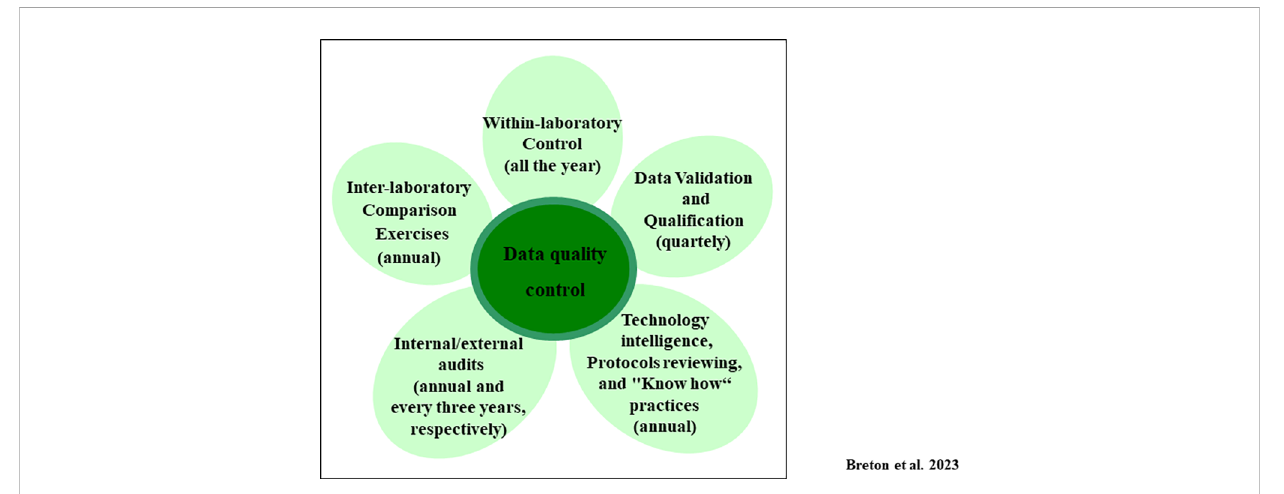
FIGURE 2 Scheme of the different actions for data quality control implemented in the SOMLIT network and their frequency based on ISO 17025